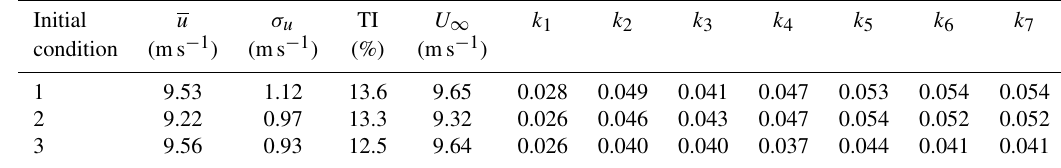
Table 2. Characteristics of wind farm initial conditions, including mean inlet velocity u , standard deviation of inlet velocity σ u , and turbu- lence intensity TI. The corresponding wake model inlet velocity U ∞ and wake expansion coefficients k n are also shown.